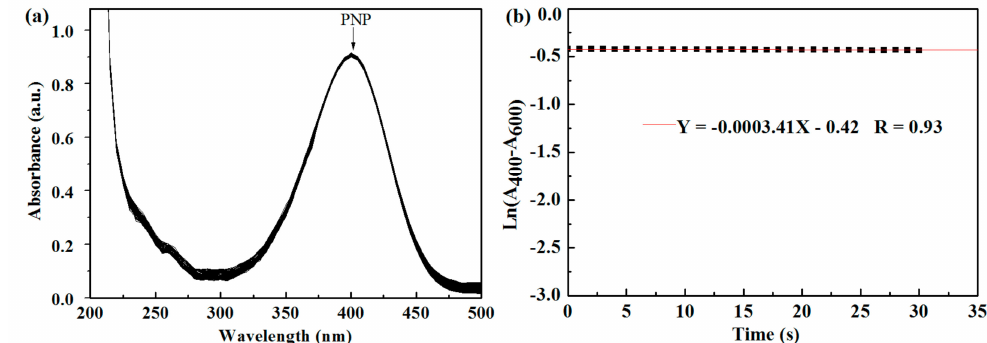
Figure 12. ( a , b ) Reduction of p -nitrophenol (PNP) catalyzed by pure HPAMAM. ( a ) UV–Vis spectra with arrows indicating the absorbance at 400 nm (peak of PNP). ( b ) Plots of the natural log of corrected absorbance at 400 nm against time.